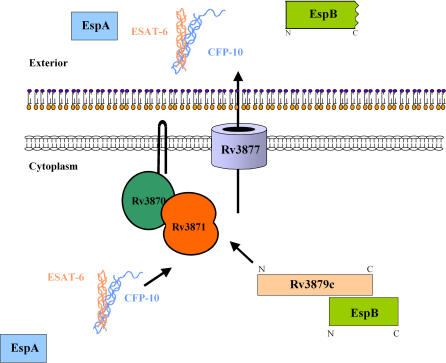
Model for EspB SecretionDepicted are the core ESX-1 components Rv3870, Rv3871, and Rv3877, as well as the ESAT-6/CFP-10 and EspB/Rv3879c complexes. Both cytosolic complexes require interaction with Rv3871 for substrate secretion.